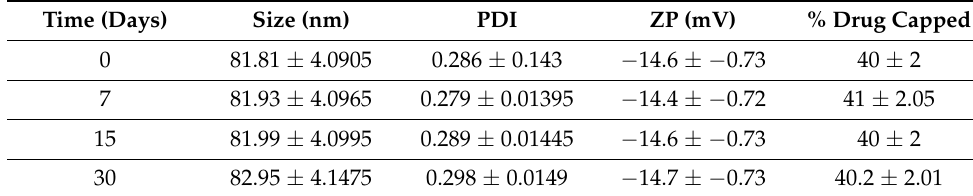
Table 1. Effect of storage conditions at ambient temperature (25 ◦ C) and time (days) on size, PDI, ZP (mV), and % drug capped of LTZ @